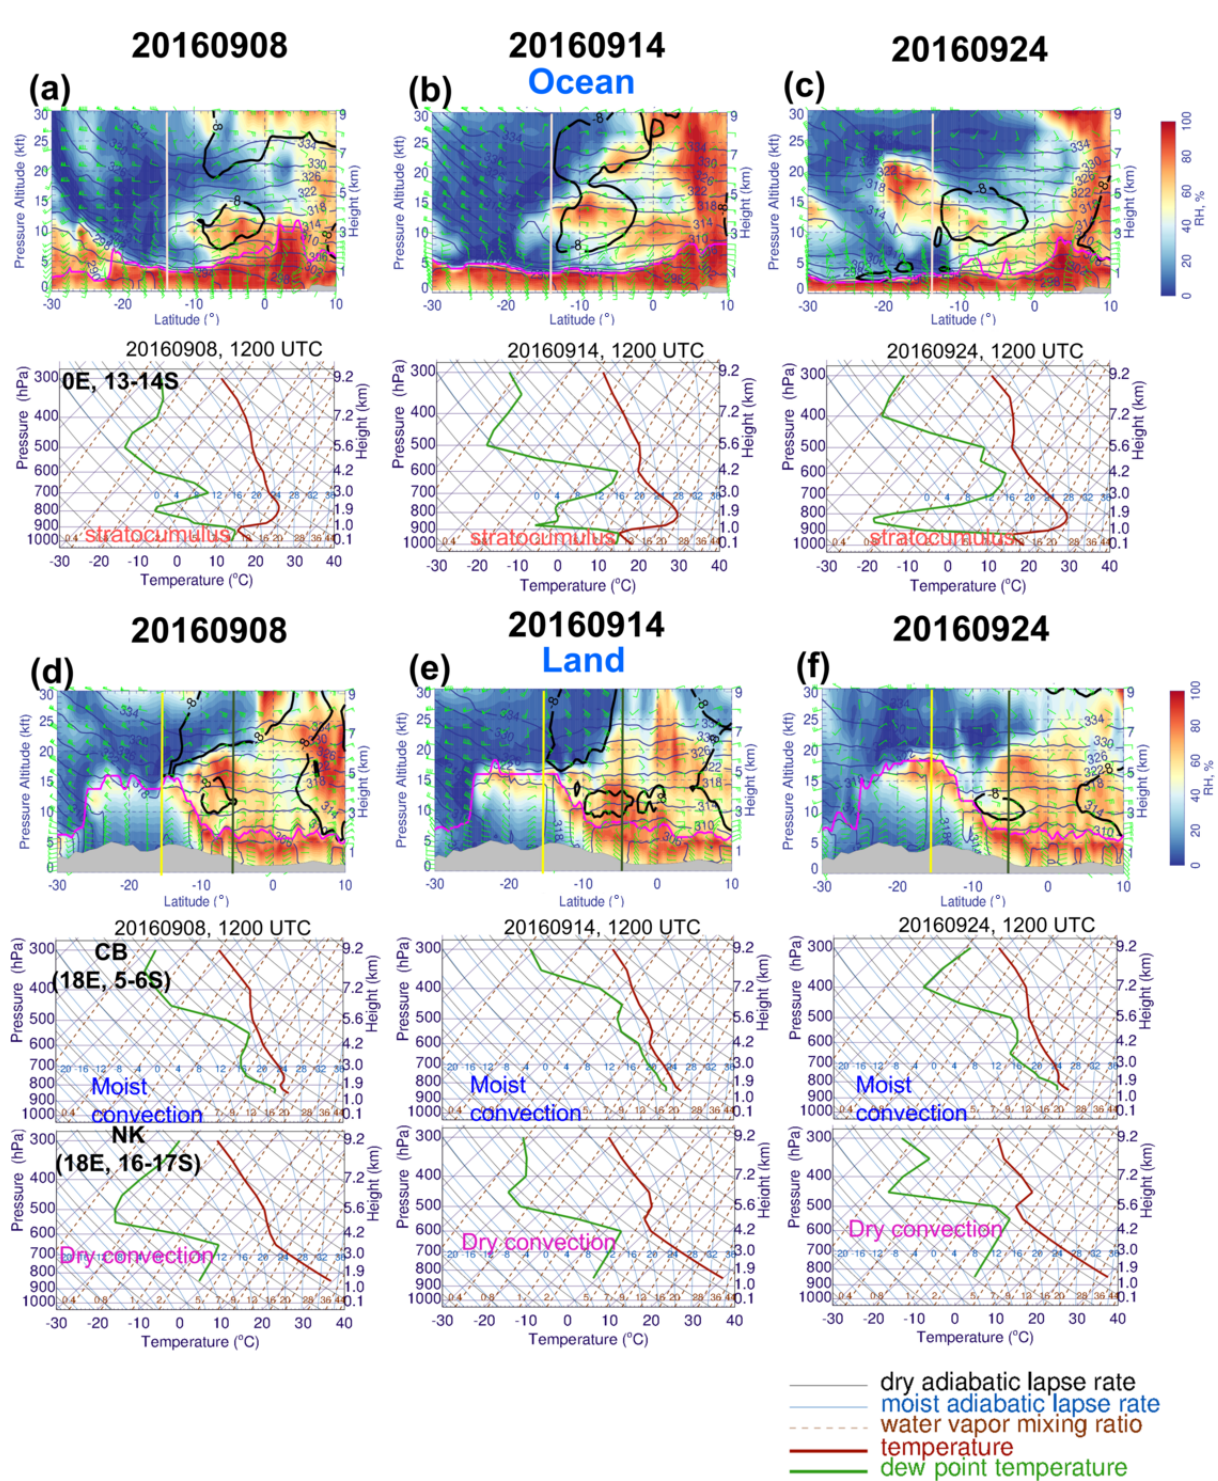
Figure 5. (a–c) Ocean, showing the latitudinal cross section of RH (shading; %), horizontal winds (wind barbs; green; ms − 1 ), θ (navy; K), and BLH (magenta; m) at 0 ◦ E (top) and a Skew-T log-P diagram averaged over 0 ◦ E and 13–14 ◦ S (bottom; from the left) at 12:00UTC on 8, 14, and 24 September 2016. Bold black contours are zonal wind ( − 8ms − 1 ). (d–f) Land, showing the same as in panels (a) – (c) , except for the cross section at 18 ◦ E and Skew-T log-P diagram averaged over 18 ◦ E and 5–6 ◦ S (CB is the Congo basin) and 18 ◦ E and 16–17 ◦ S (NK is Namibian–Kalahari dryland). The gray-filled area represents the topography. The vertical lines in the cross-sectioned plots refer to the latitude we